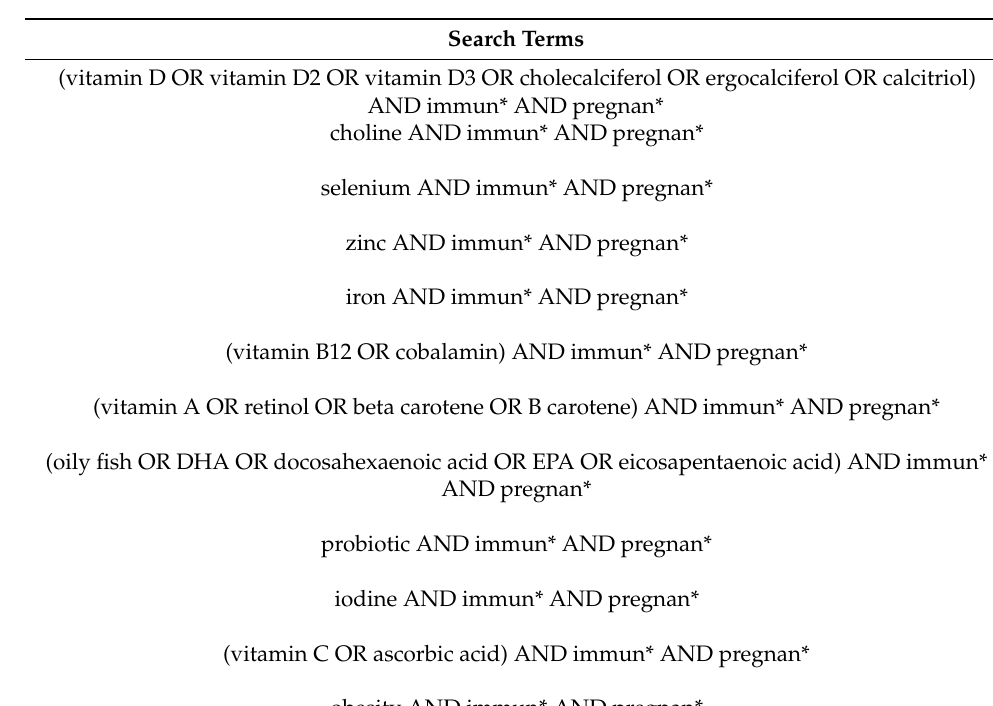
Table 1. Search terms.